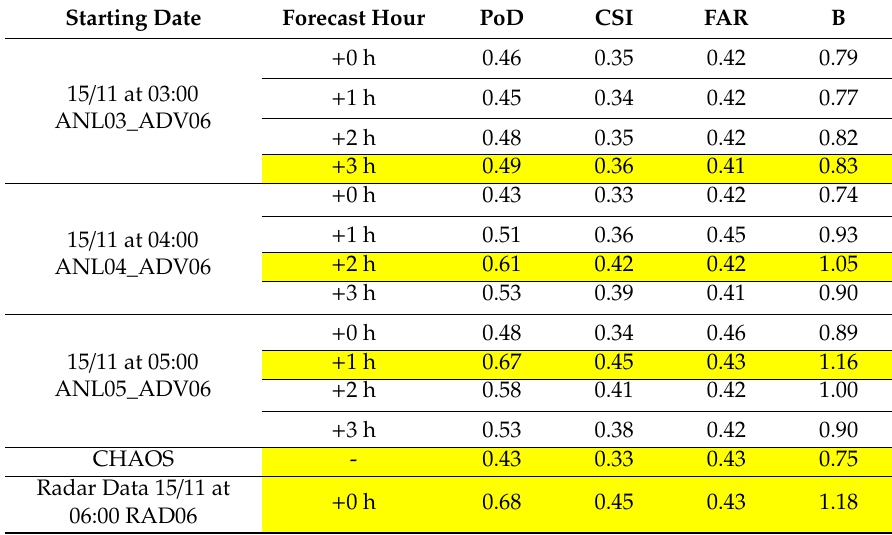
Table 3. Statistical indices for all WRF-Hydro simulations, using input data from LAPS-advected fields. The time of the peak flood, i.e., 06:00 UTC, was noted using the yellow color. Additionally, the comparison with the XPOL radar data presented in the bottom row was made as reference, facilitating the assessment of the